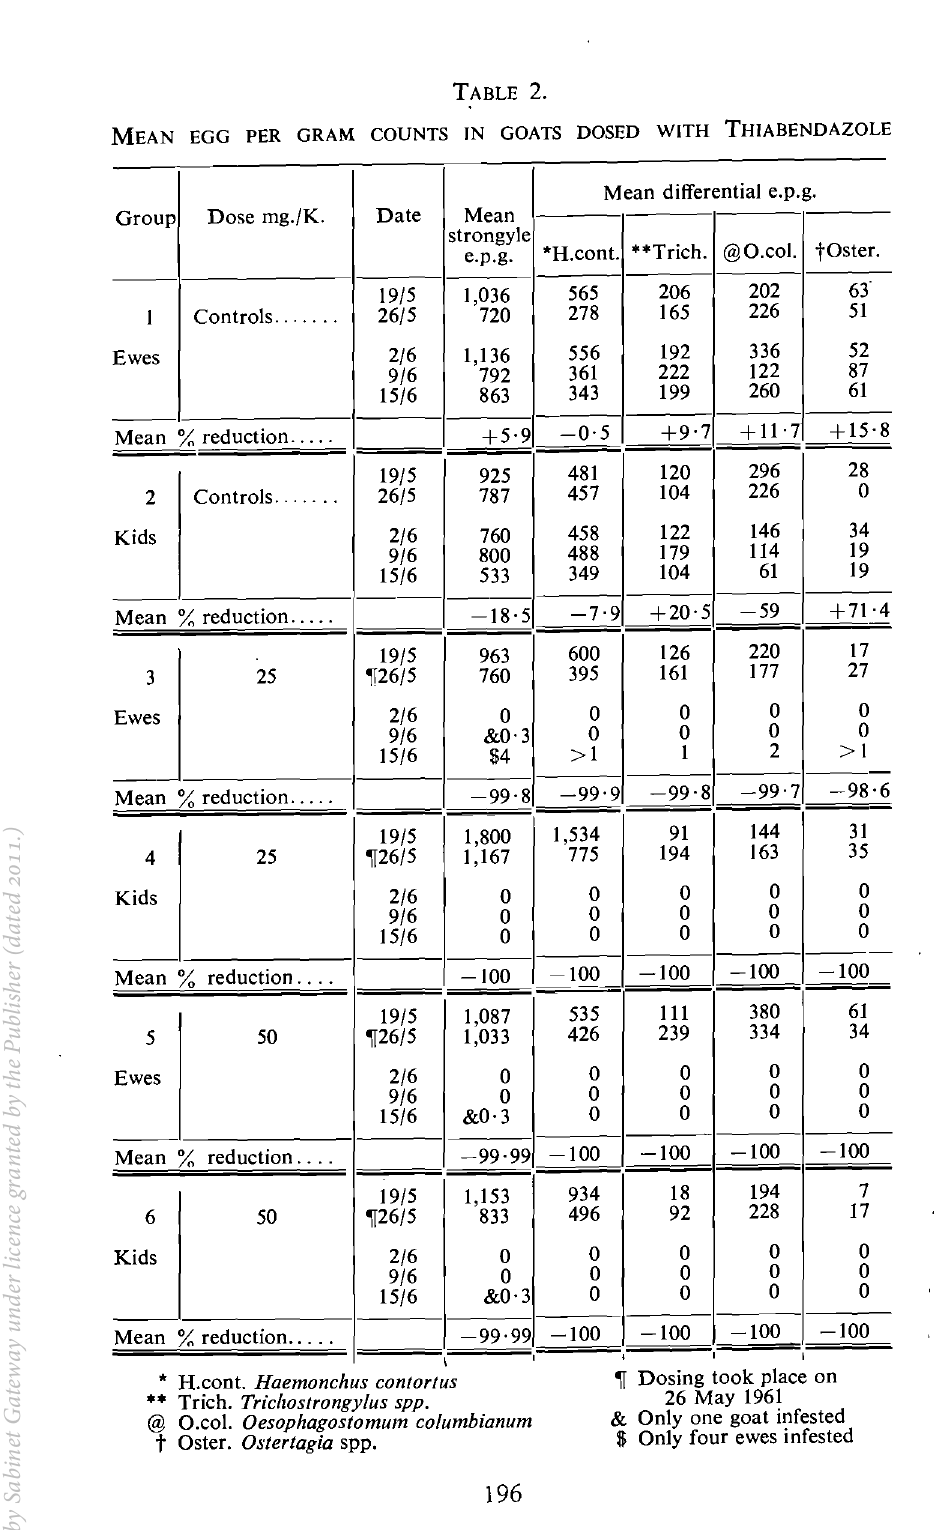
MEAN EGG PER GRAM COUNTS IN GOATS DOSED WITH THIABENDAZOLE